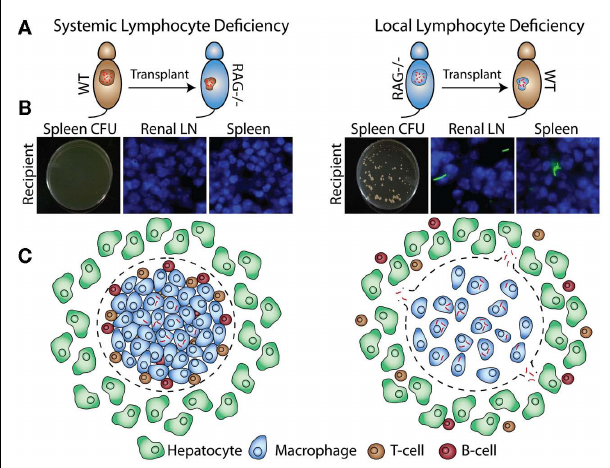
FIGURE 4 | Bacillus Calmette–Guerin-infectedWT or RAG KO donors are transplanted intoWT or RAG KO recipients (A). Four weeks after transplantation, bacterial dissemination is measured by CFU and fluorescent microscopy of recipient spleen and renal lymph nodes (B) . Transplantation of infected RAG KO donors intoWT recipients, but notWT donors into RAG KO recipients, results in bacterial dissemination (C)